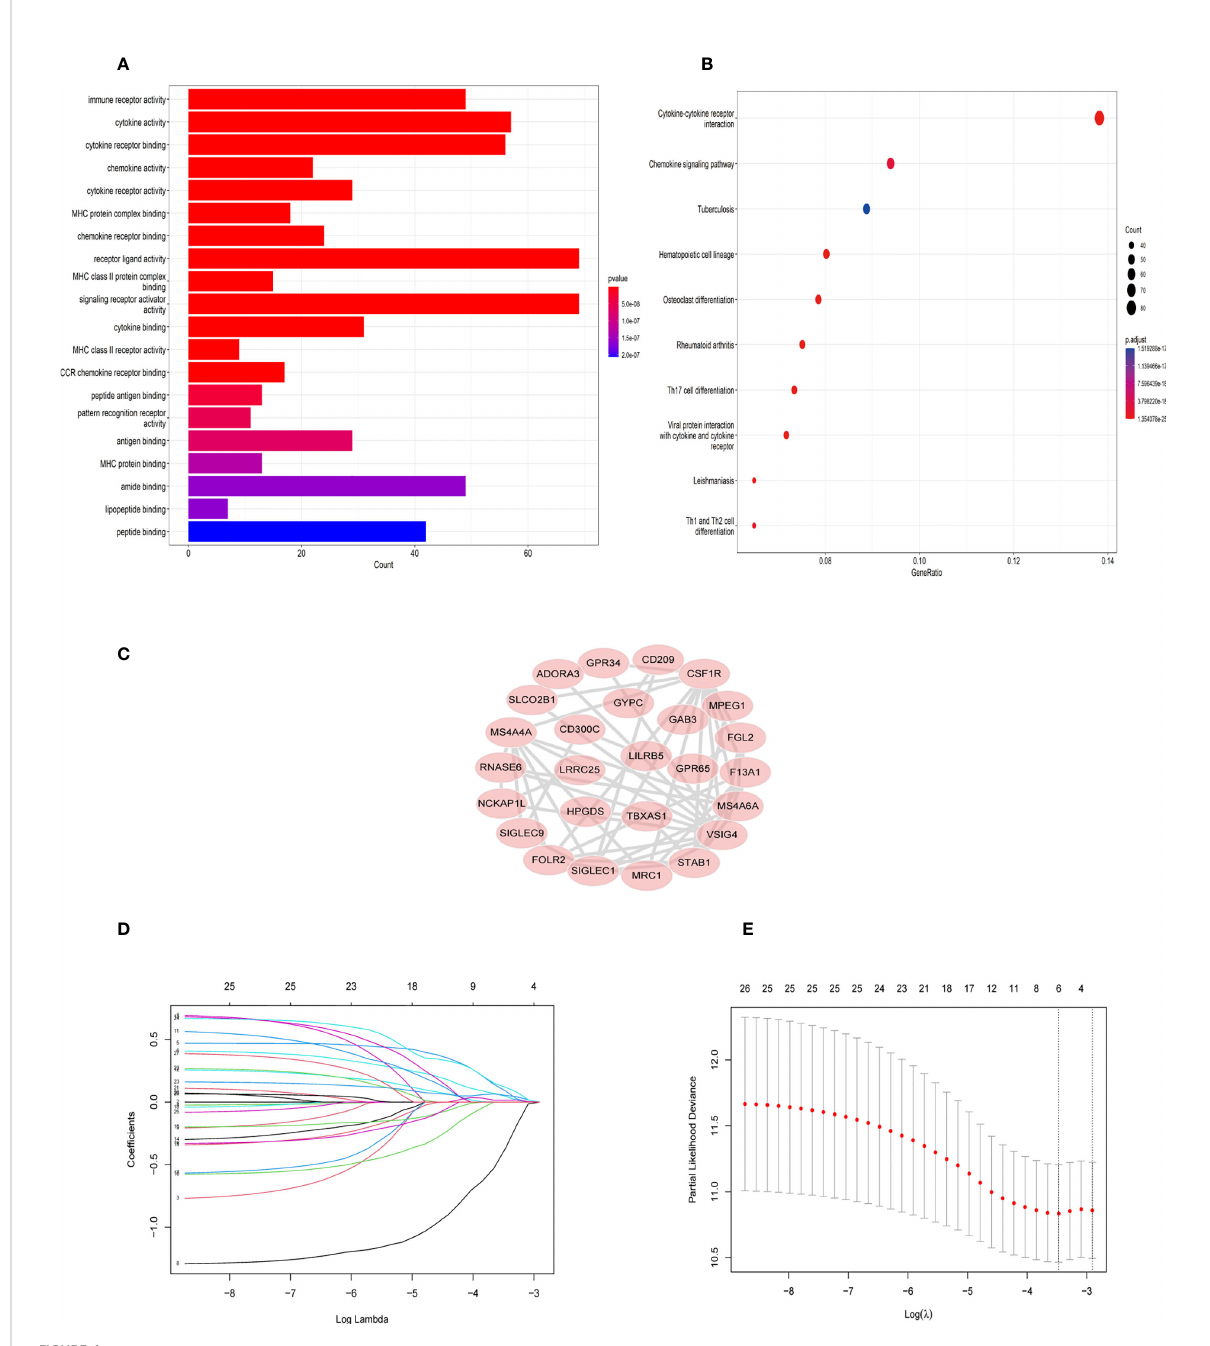
FIGURE 4 GO and KEGG enrichment analysis in blue module genes and identi fi cation of six TAM gene signature. (A) Gene ontology (GO) enrichment in blue module genes. (B) Kyoto Encyclopedia of Genes and Genomes (KEGG) signaling pathway analysis for blue module genes. (C) The network of 26 TAM related genes fi ltered by the condition (GS>0.65,MM>0.8) (D) LASSO regression analysis was used to identify the six genes signature. (E) The cross-validation in the LASSO